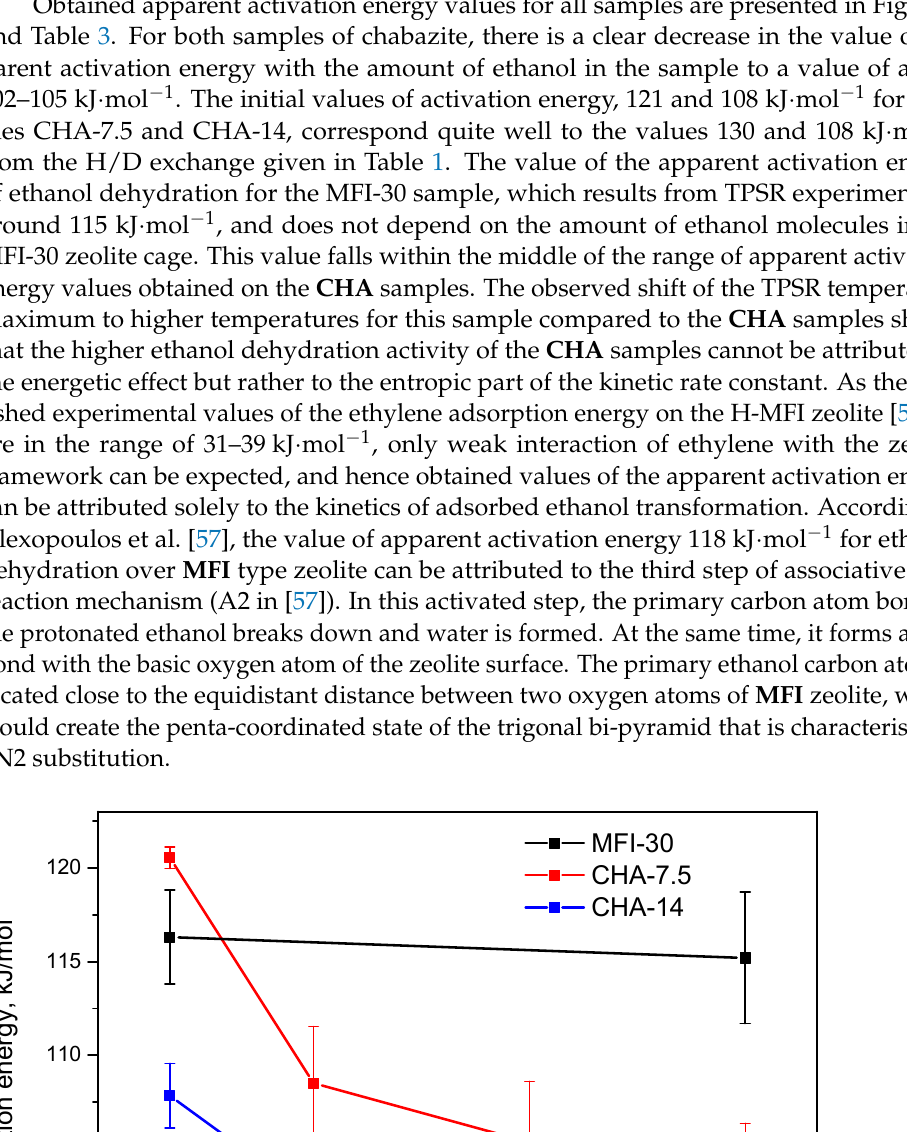
Table 3. TPSR experimental data and obtained values of activation energy.